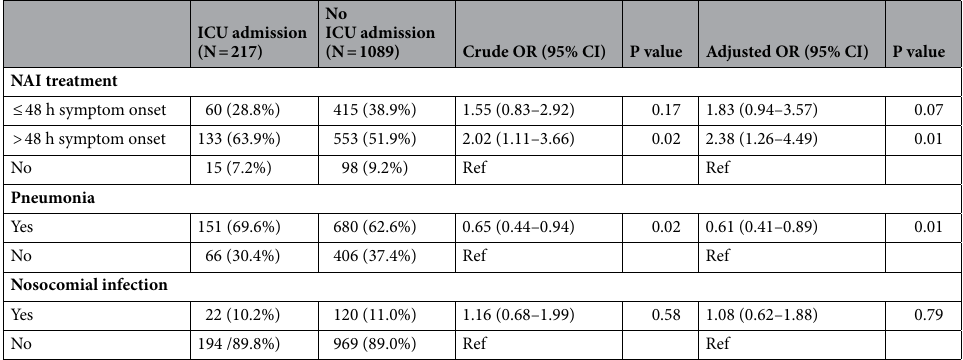
Table 2. Factors associated with ICU admission in hospitalized severe influenza patients. COPD: chronic obstructive pulmonary disease, NAI: neuraminidase inhibitors. a Hemoglobinopathy, severe neuromuscular disease or cognitive dysfunction.